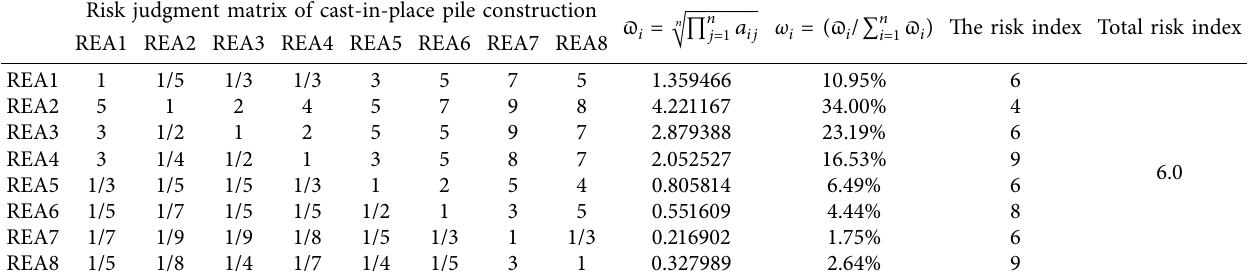
Table 19: Risk judgment matrix of cast-in-place pile construction.